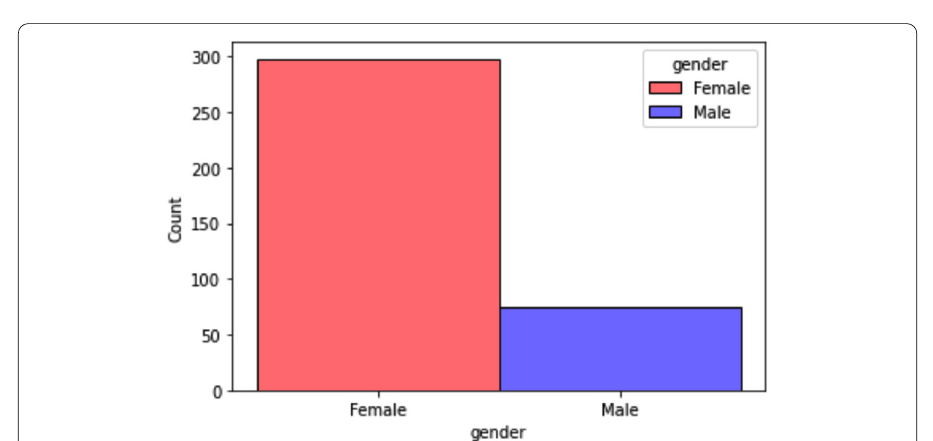
Figure 4 Distribution of Gender